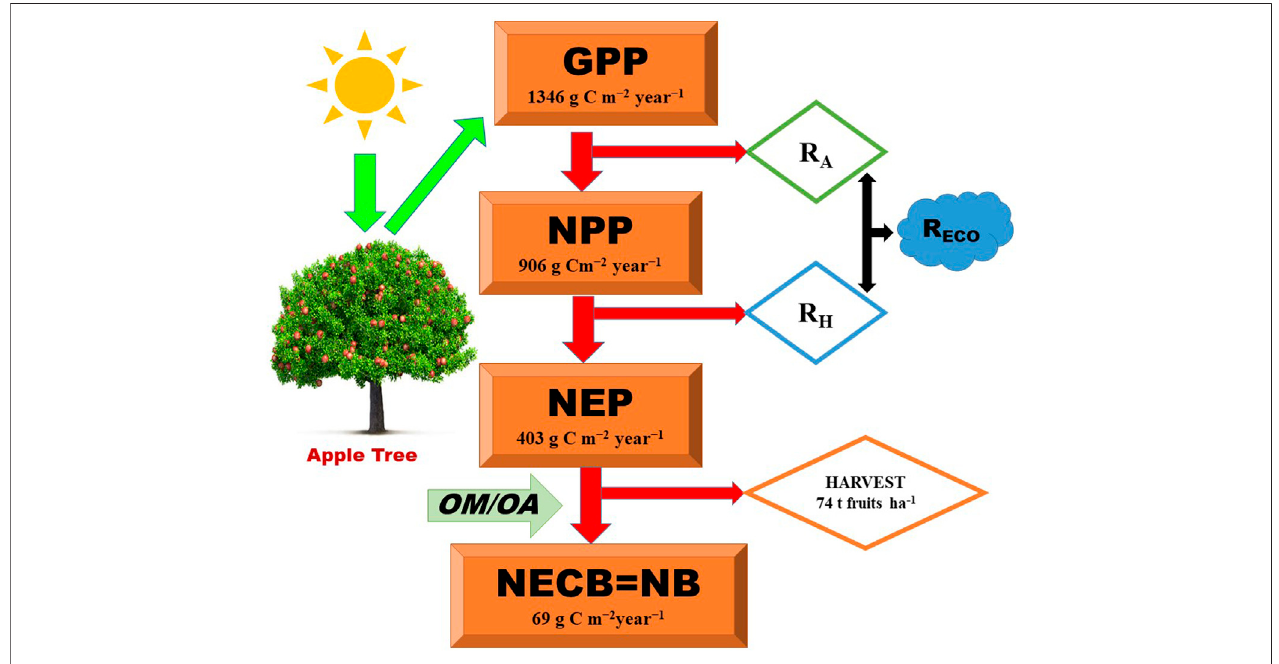
FIGURE 2 | Relationship between fruit trees and carbon sequestration.